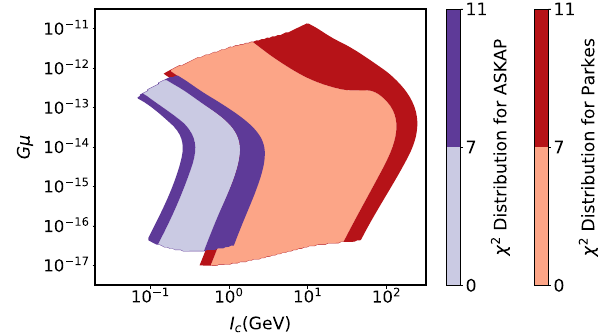
Fig. 1 The χ 2 distribution with 2 σ significance for Parkes (red shadow) and ASKAP (purple shadow), respectively Table 2 Observational parameters including redshift, energy flux and observed frequency for Parkes and ASKAP are listed Parkes ASKAP